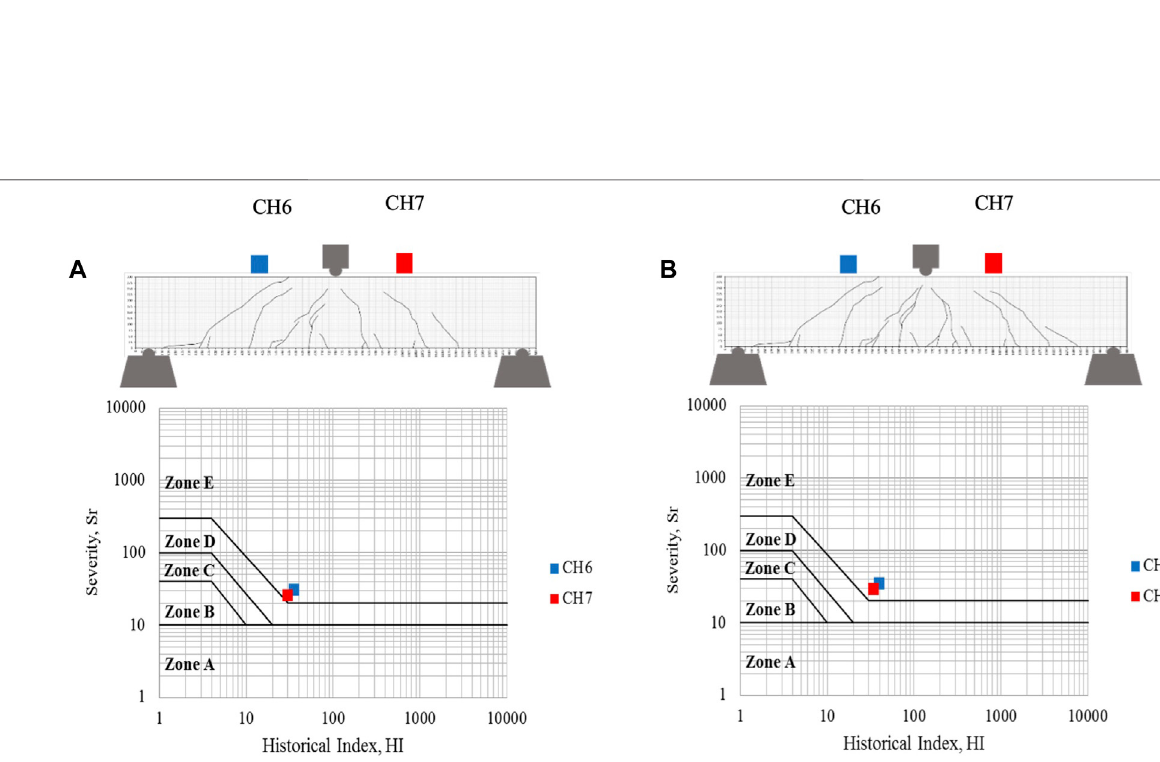
Frontiers in Mechanical Engineering |